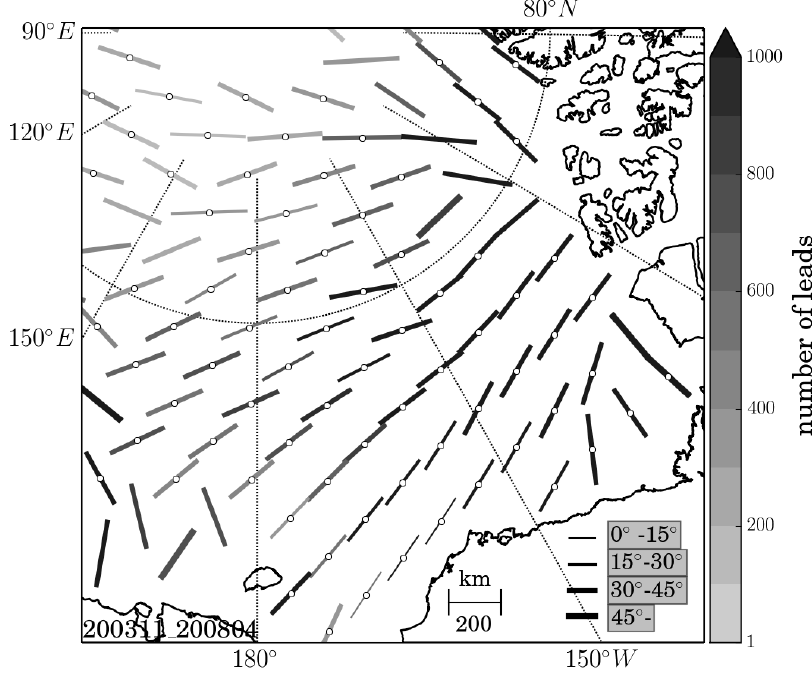
Figure 13. Average lead orientation from 2003 to 2008 in an identically rotated map as the map in Figure 6 of Miles and Barry [4]. Grey colors display the number of leads while the width of a lead measures the standard deviation of all lead orientations in a 200 km × 200 km cell. White dots on top of a mean lead orientation indicate a statistically significant preferred orientation